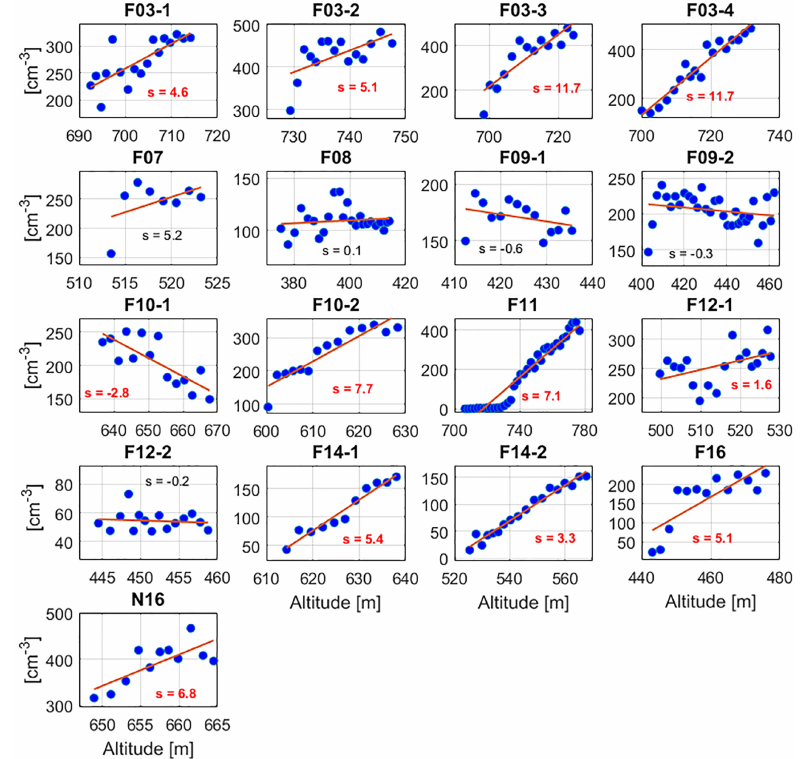
Figure 5. Particle concentration in diameter range 110–3400 (PCASP) as a function of altitude in the EIL. Linear fits and slopes (s, units of cm − 3 m − 1 ) are shown in each panel. Slopes in red font correspond to statistically significant correlations at 95 % based on a two-tailed t